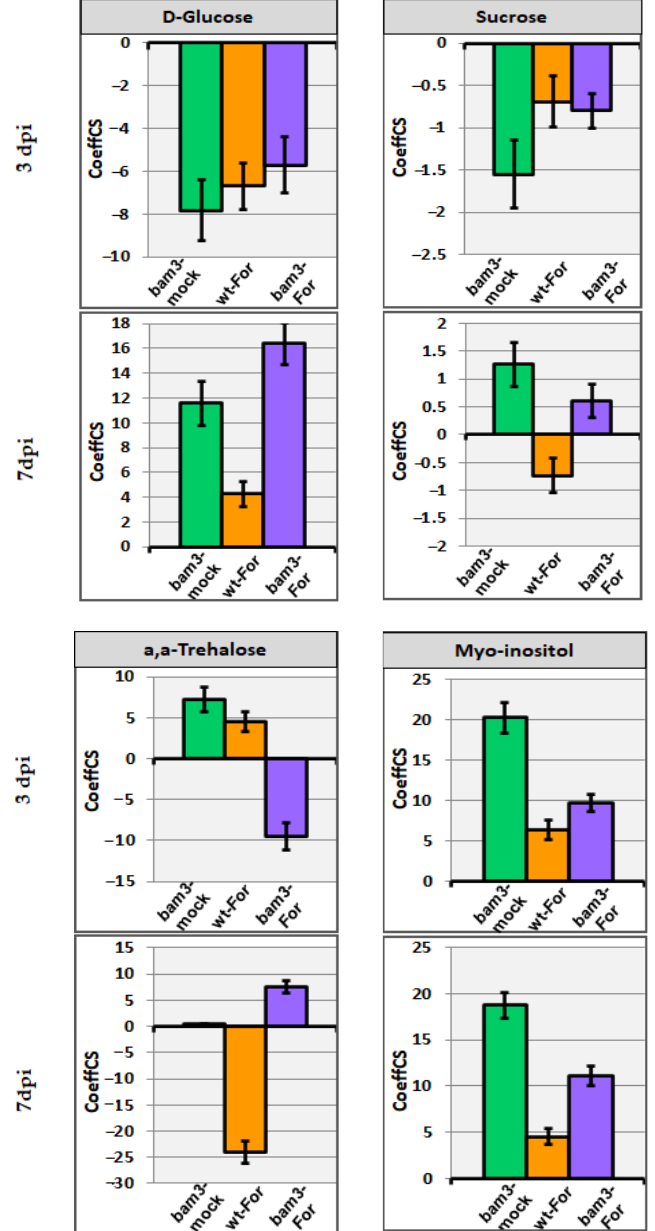
Figure 6. Centered partial-least squares (PLS) regression coefficients (CoeffCS) for the selected metabolites belonging to carbohydrates; D-glucose, sucrose, a,a-trehalose, and myo-inositol. CoeffCS represents the relative differences in metabolite concentrations among mock bam3 plants, For -inoculated wt plants, and For -inoculated bam3 plants compared to wt mock plants (x axis) at three and seven dpi, displayed with Jack-knifed confidence intervals ( p < 0.05).